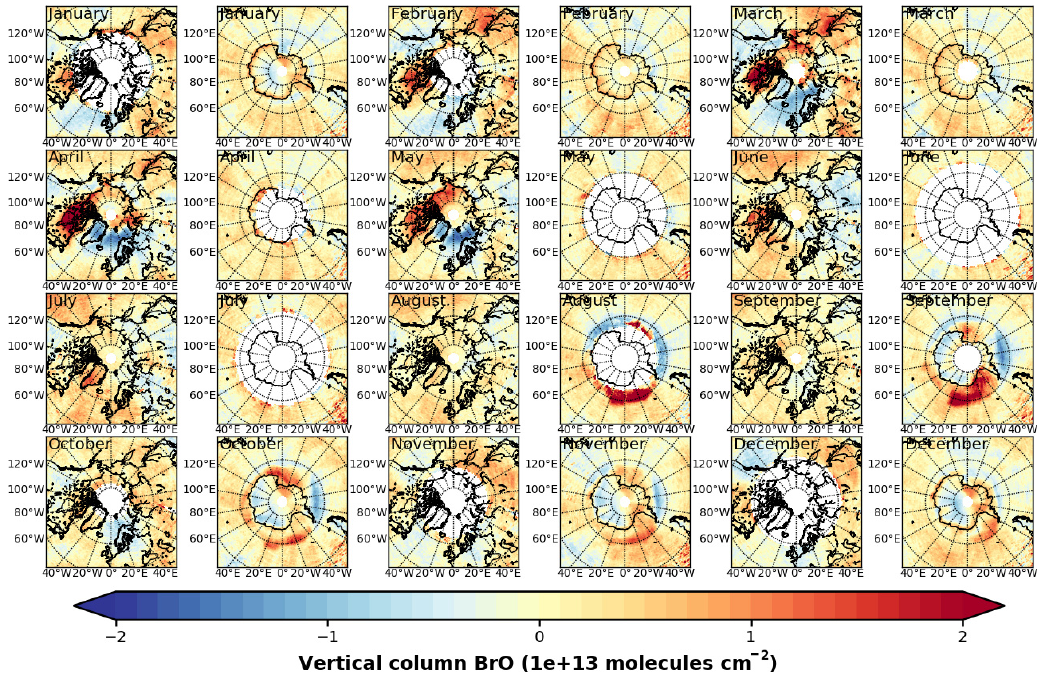
Figure A3. Anomalies of GOME monthly mean VCD of BrO for the Arctic and Antarctic with respect to monthly averaged zonal mean (see Sect. S4).